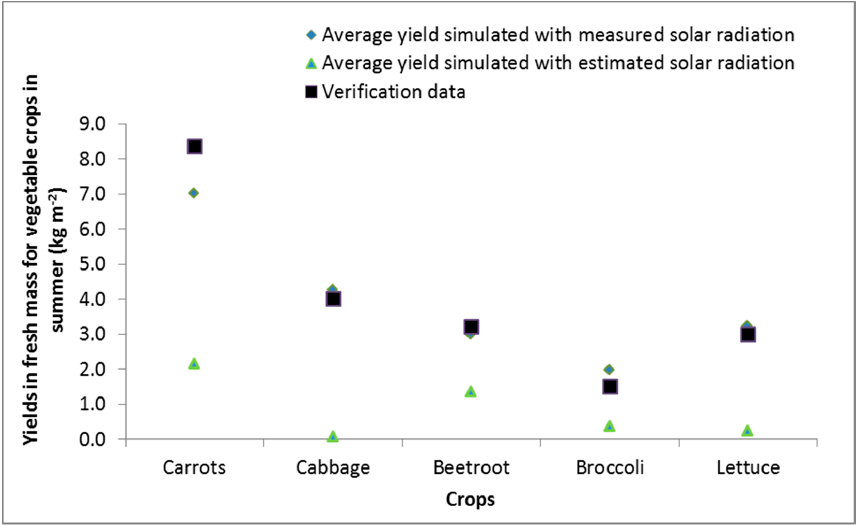
Figure 2. Soil Water Balance (SWB) model results for simulated and measured yield of carrots, cabbage, beetroot, broccoli and lettuce grown in summer with measured and estimated solar radiation.